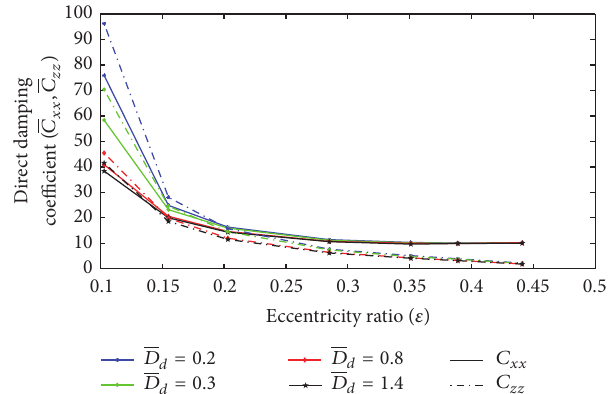
Figure 21: Effect of dam depth ratio on direct damping coefficient.